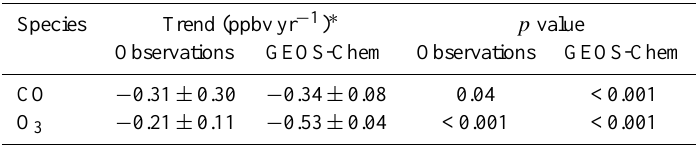
Table 2. CO and O 3 trends obtained for PMO observations and GEOS-Chem output. Species Trend (ppbvyr − 1 ) ∗ Observations GEOS-Chem